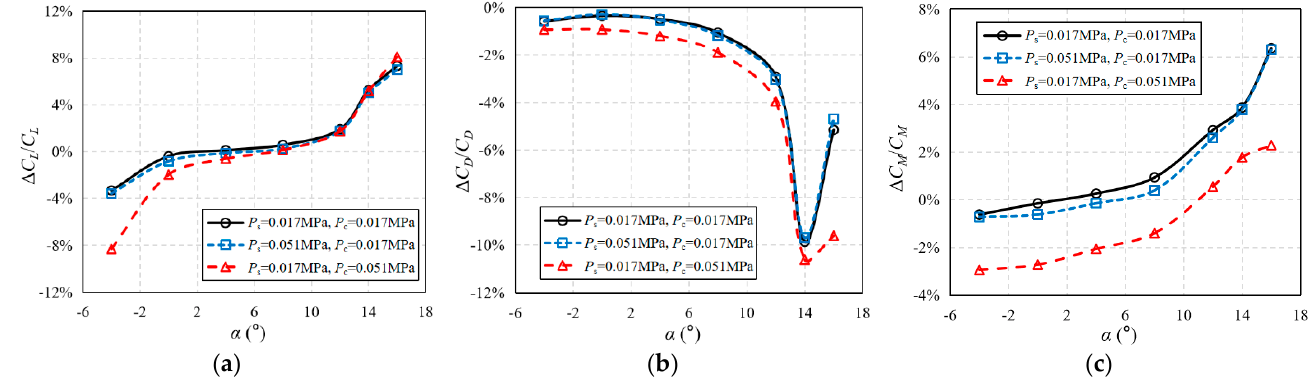
Figure 29. Aerodynamic performance of wing under different prestress: ( a ) v = 6.4 m/s; ( b ) v = 9.0 m/s; ( c ) v = 11.0 m/s.